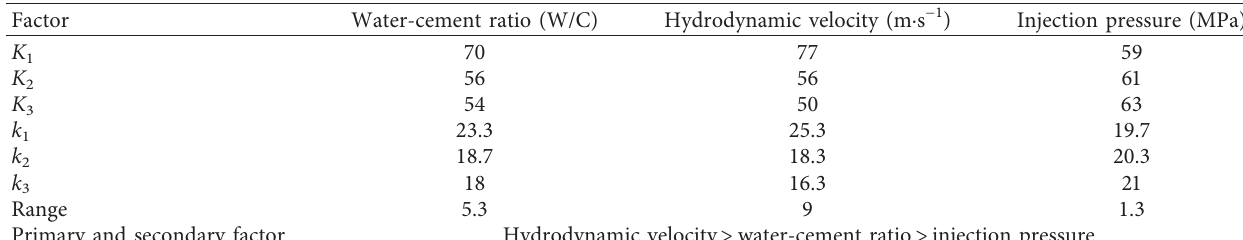
Table 5: Analysis of the slurry deposition thickness in the 50 mm diameter